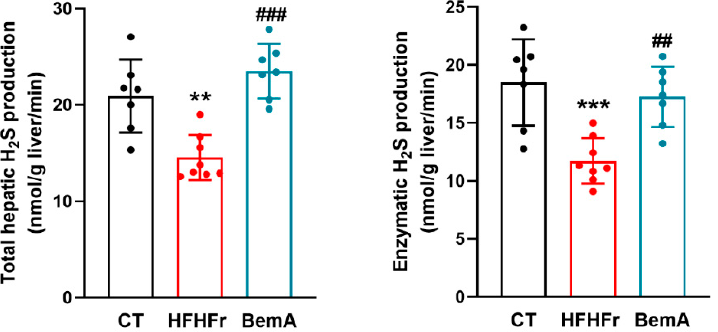
Figure 1. Effect of HFHFr supplementation and BemA treatment on Sprague-Dawley female rats’ liver total and enzymatic H 2 S production. Bar plots show liver total and enzymatic H 2 S production as mean ± SD, as well as individual values from 7–8 tissue samples, corresponding to the three experimental groups studied: CT (control), HFHFr (high-fat high-fructose), and BemA (HFHFr treated with BemA) female Sprague-Dawley rats. ** p < 0.01, *** p < 0.001 vs. CT; ## p < 0.01, ### p < 0.001 vs. HFHFr.